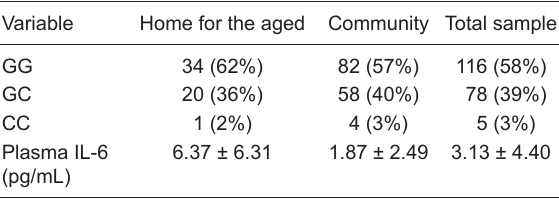
Table 2. Distribution of genotypes and plasma IL-6 levels in el- derly women living in homes for the aged or in the community.